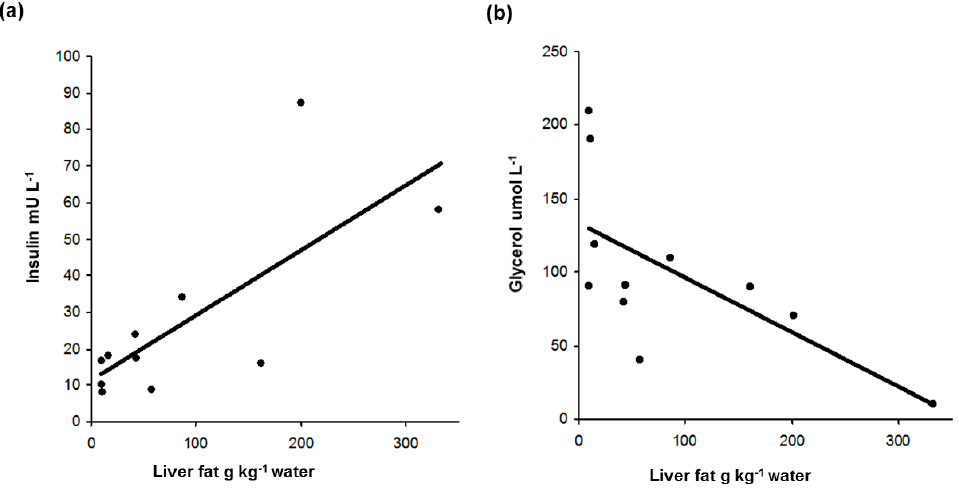
Figure 2. Cont. Figure 2.